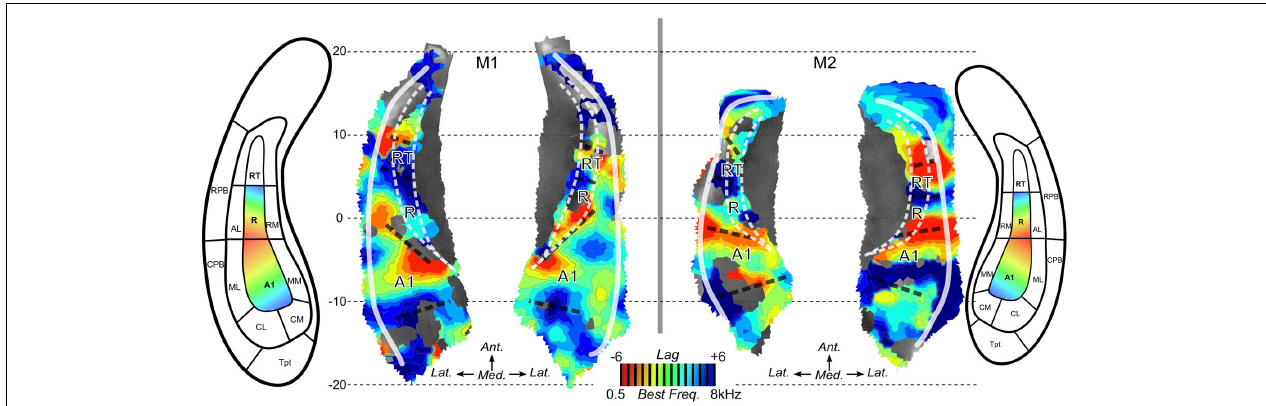
FIGURE 5 | Best frequency maps. Maps of best frequency/lag for maximized cross-correlation across run types in M1 and M2. Iso-frequency contours are also mapped. Aligned anatomical atlases are also shown to